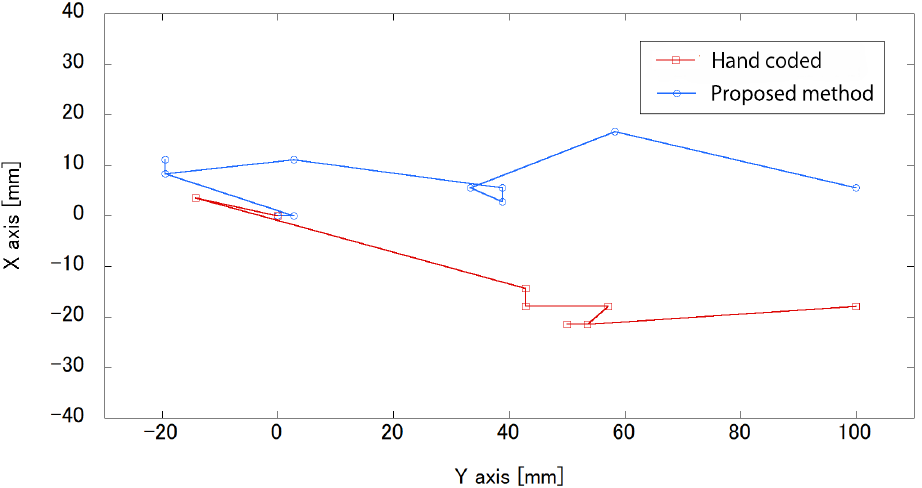
Figure 11. Movement trajectory of Robot 2 when the action-value function is transferred from the virtual agent through body calibration. As a comparison, the movement trajectory of Robot 2 during the transfer of learning using hand-coded inter-task mapping is